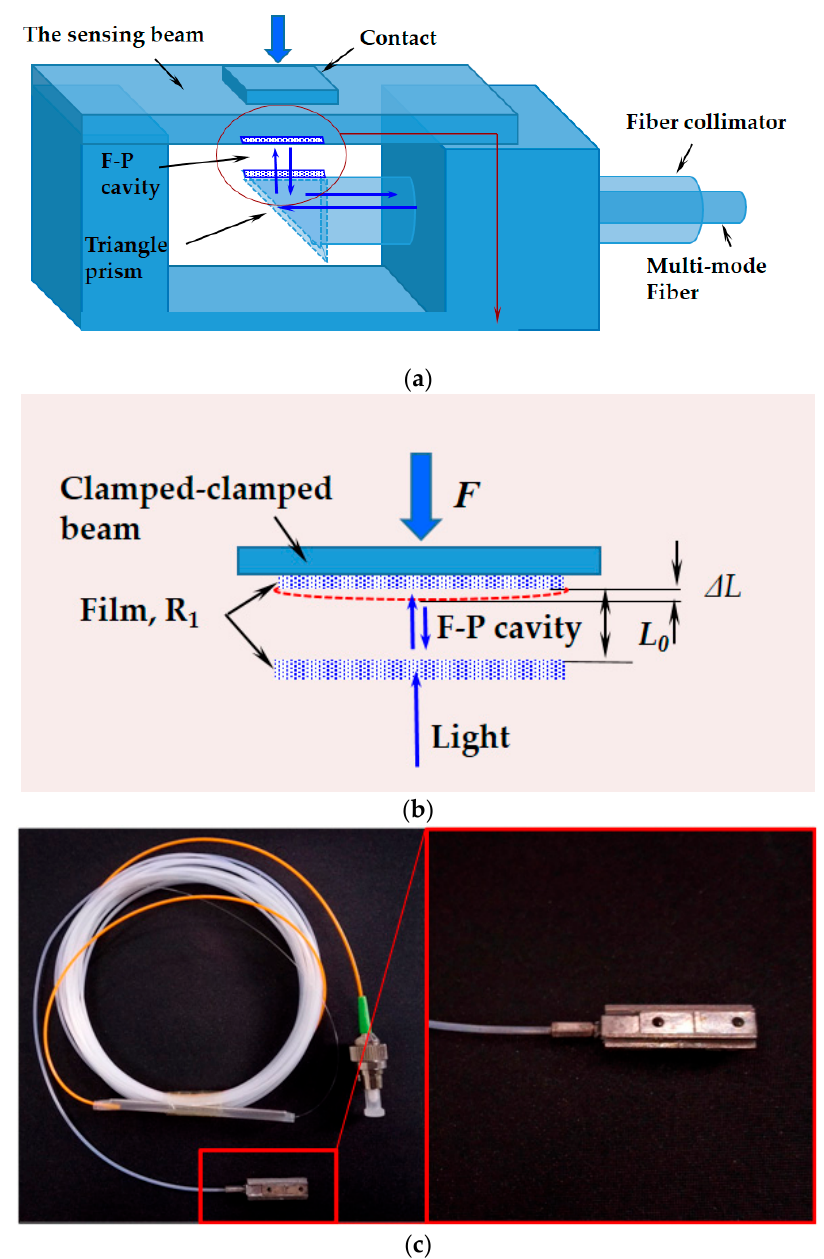
Figure 4. ( a ) Three-dimensional structure of our Fabry-Perot (F-P) force sensors with clamped-clamped beam element; ( b ) a simplified structure of the F-P cavity length change induced by the force F for a clamped-clamped beam; ( c ) the encapsulated F-P force sensor with the overall dimensions of 17 mm × 5 mm × 3 mm (L × W × H).